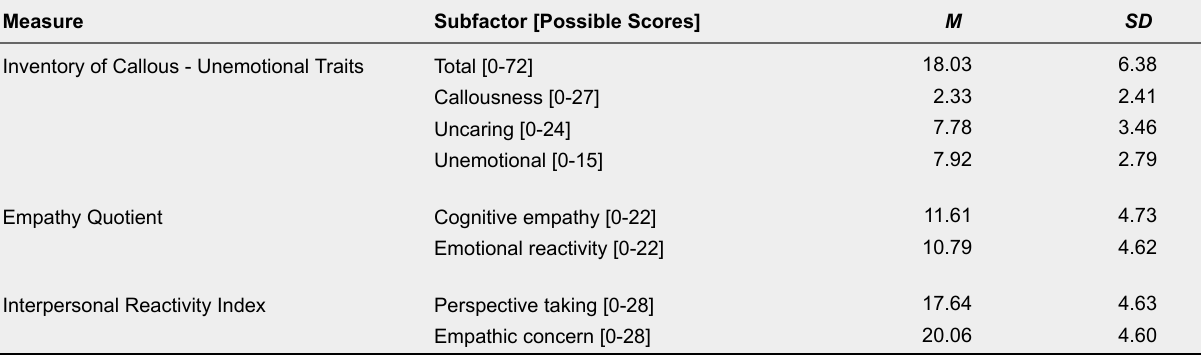
Descriptive Statistics for the Self-Report Measures of CU Traits and Empathy Measure Subfactor [Possible Scores] M Inventory of Callous - Unemotional Traits